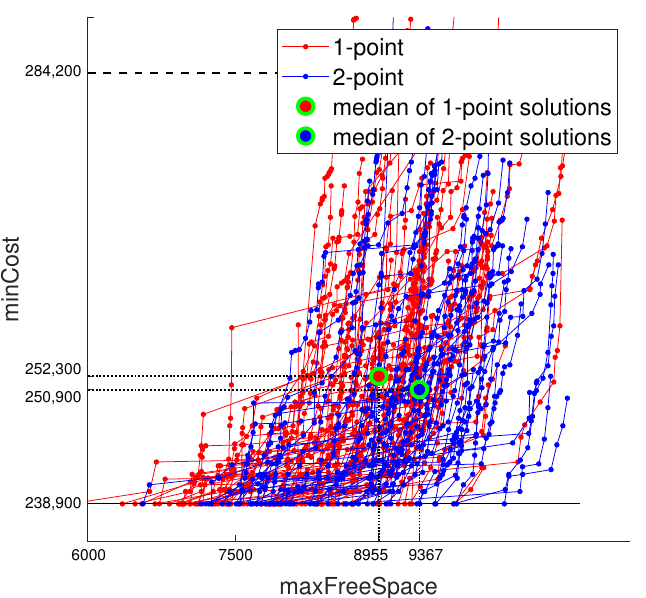
Figure 6. Comparison of MOEA_T_T using 1-point and MOEA_T_T using 2-point crossover. The sets of non-dominated solutions generated in 100 independent runs are shown.